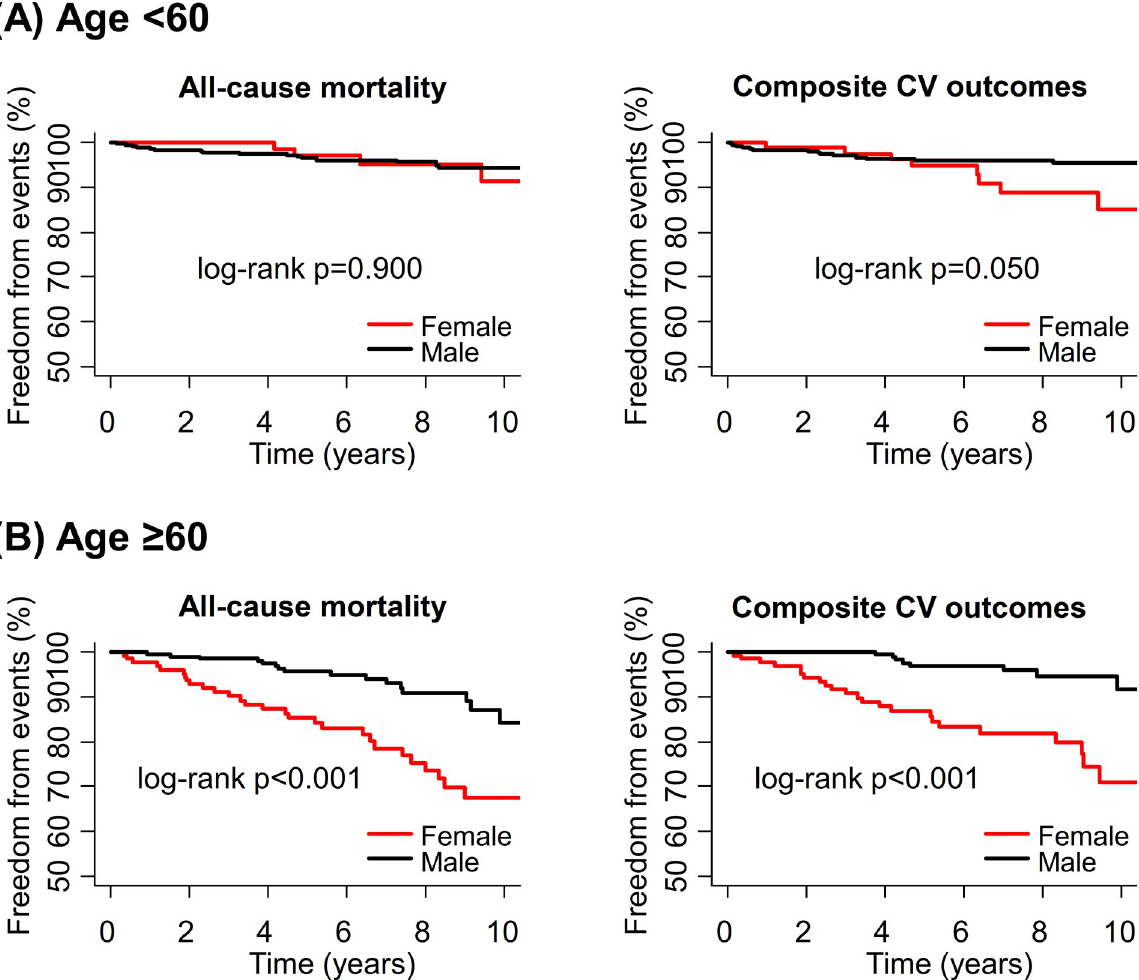
Fig 2. Sex differences in clinical outcomes, stratified by age. (A) Below the age of 60, there was no significant difference in survival and composite cardiovascular outcome between the sexes under the age of 60, though there was a non-significant trend for higher incidence of the latter in women. (B) Over the age of 60, women showed worse survival and higher incidence of the composite cardiovascular outcomes compared to